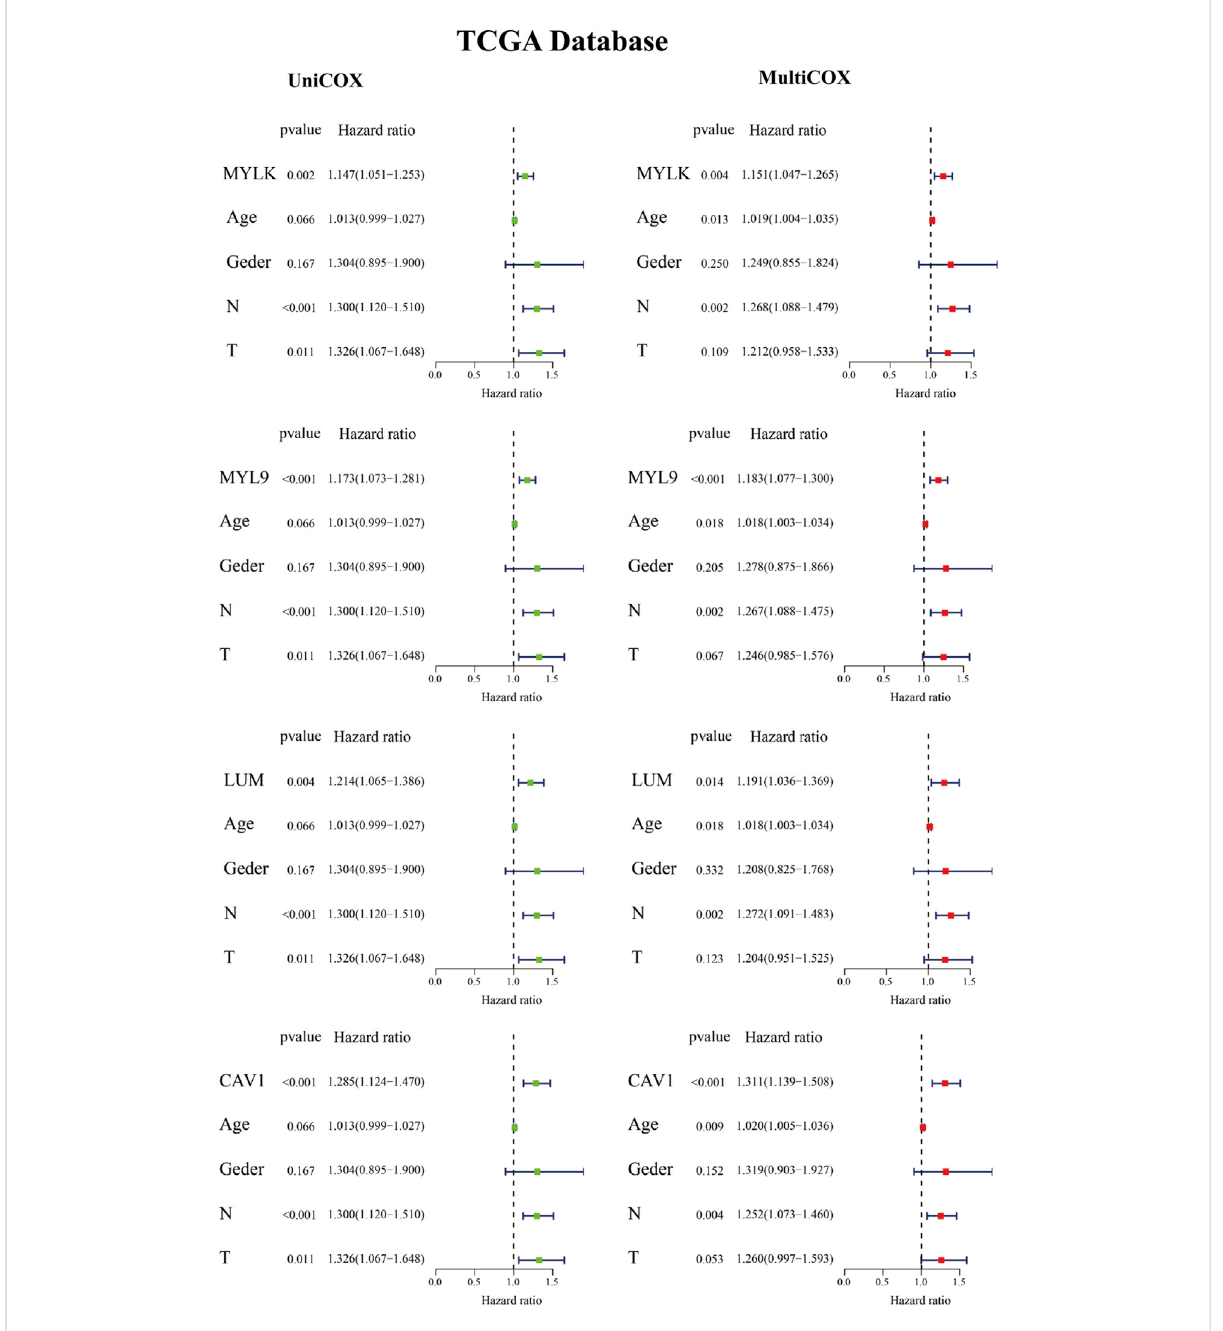
FIGURE 3 Independent prognostic analysis of key genes in TCGA